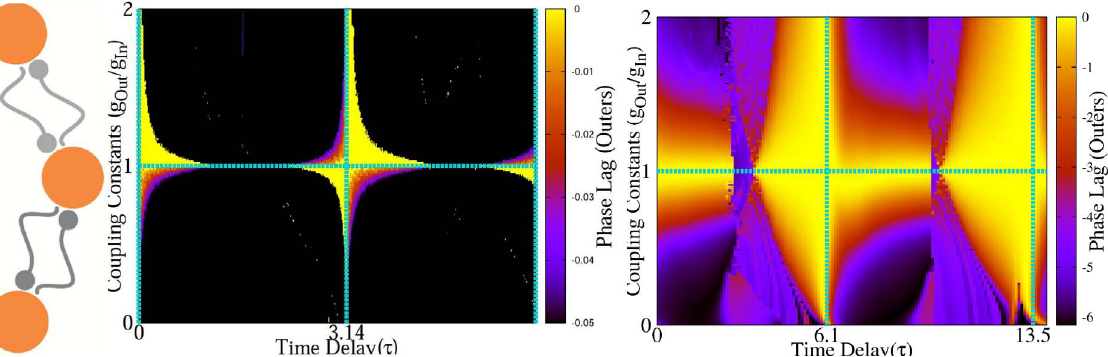
Fig. 9. Asymmetric variation of synaptic constants. The time lag of firing of the neurons is shown as a function of delay time and ratio of synaptic constants in an asymmetrix case. Numerical results confirm outcome of analytic calculations for the phase lag of phase oscillators of type-II (left panel). Right panel shows the results for HH neurons. Again zero-lag synchrony is seen for t ^ T = 2 and t ^ T .